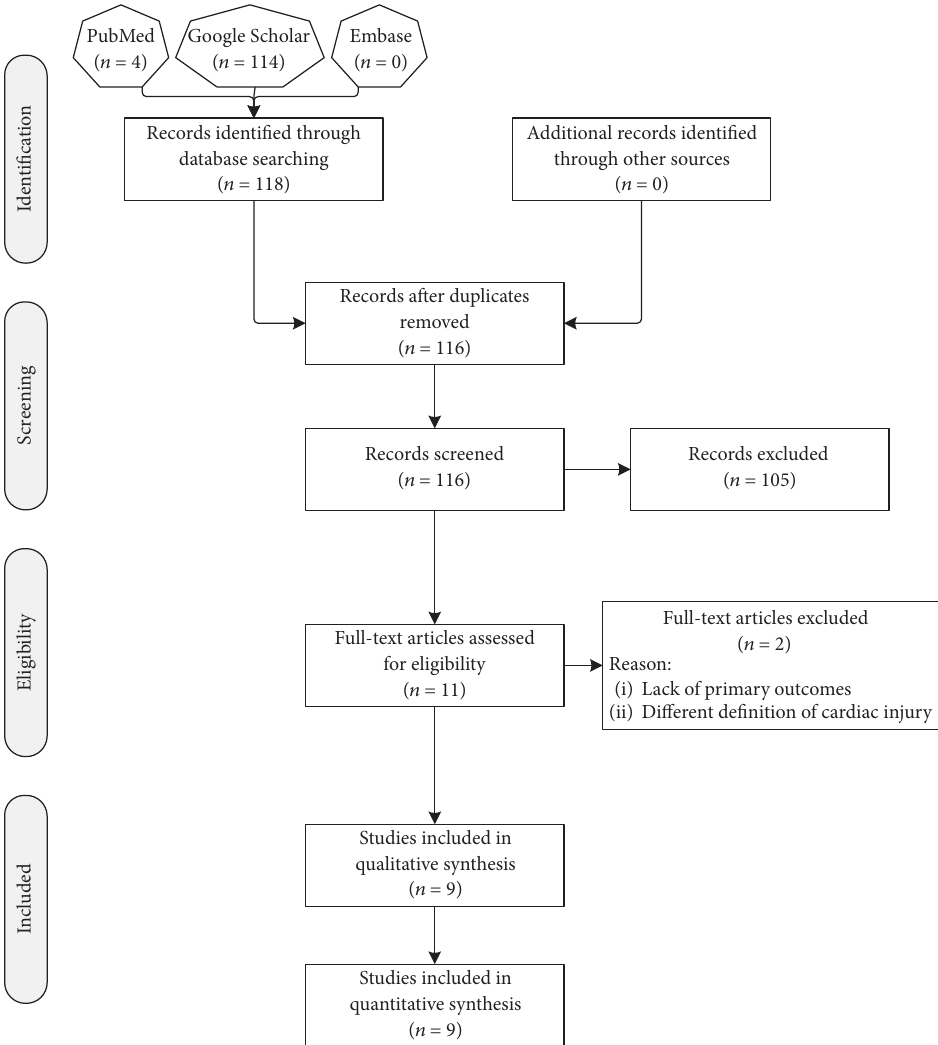
Figure 1: Flow chart showing the search process employed in the current